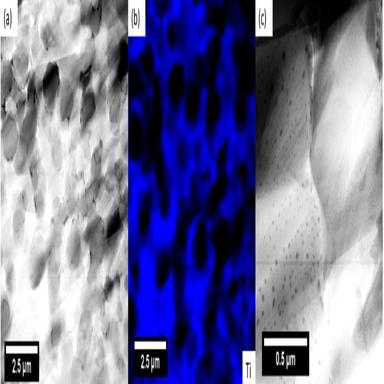
Transmission electron micrographs showing: (a) Individual alumina particles (darker) and the "coral" network formed by connected alumina particles under bright field mode, (b) corresponding EDS map of titanium further proves the composition of particles and highlights the alumina network, and (c) the grain boundary between two titanium aluminide grains.